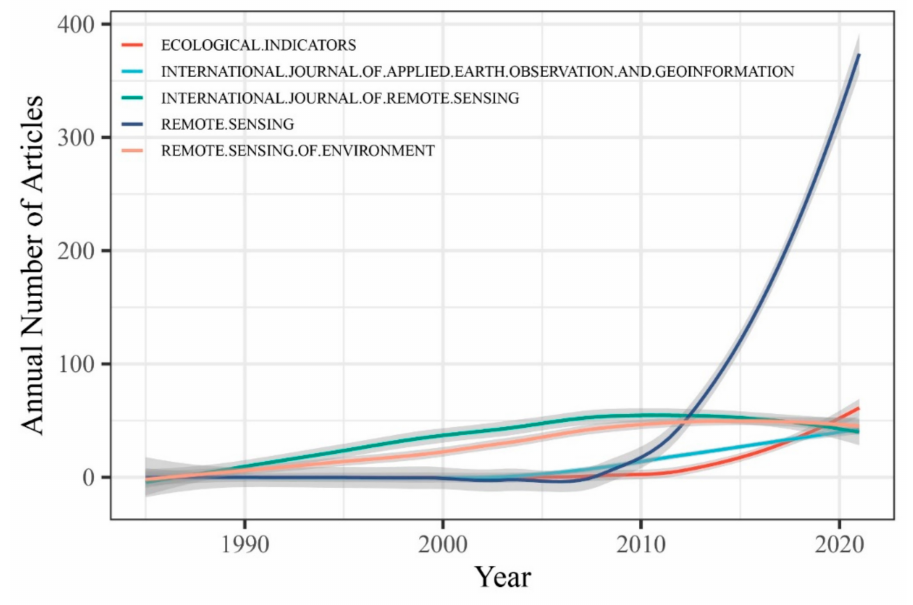
Figure 7. Temporal analysis of the publication source of NDVI-related research.